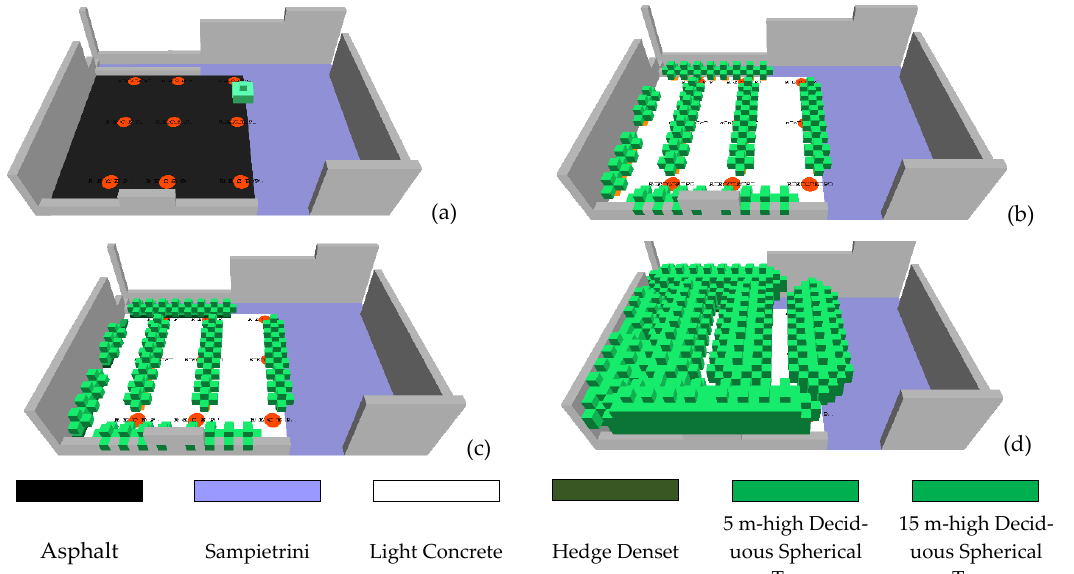
Figure 3. Scenarios implemented and analyzed with Envi-Met: ( a ) First scenario (AS); ( b ) Second scenario (LC+G1); ( c ) Third scenario (LC+G2); ( d ) Fourth scenario (LC+G3).